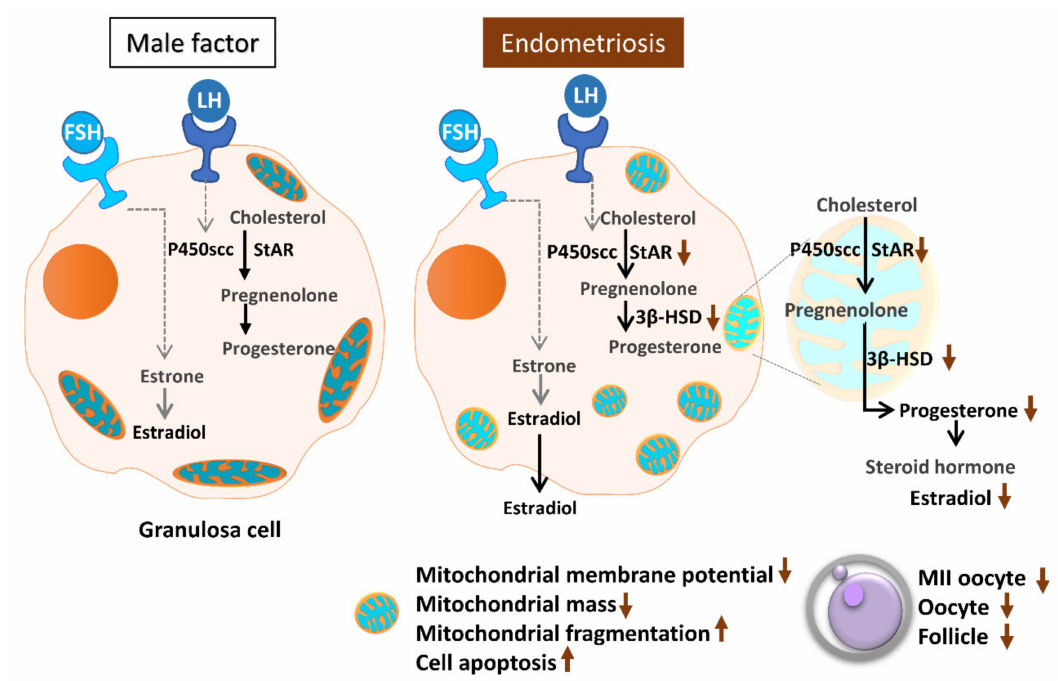
Figure 11. Schematic diagram summarizing the mitochondrial function in modulating human granulosa cell steroidogenesis and female fertility. Mitochondrial dysfunction of human granulosa cells may contribute to the decline of steroidogenesis, decreased fertilization rate, oocyte maturation rate, and oocyte quality, and it can ultimately jeopardize